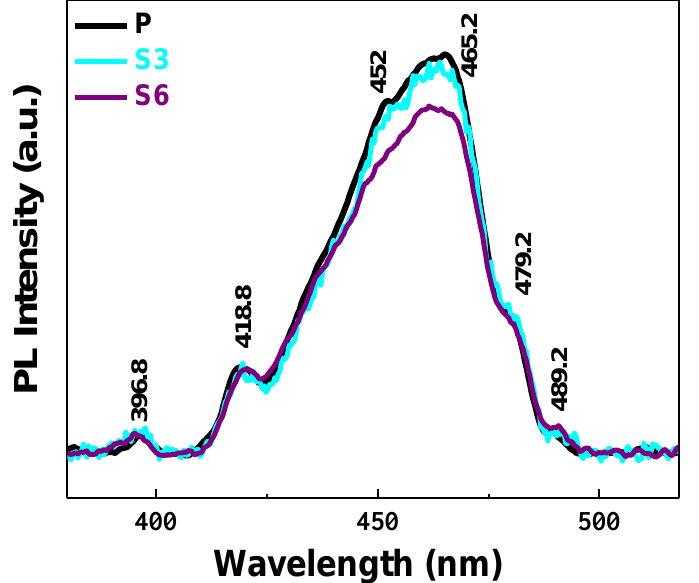
Figure 9. Photoluminescence (PL) spectra of pure and Zn-doped CuO films.